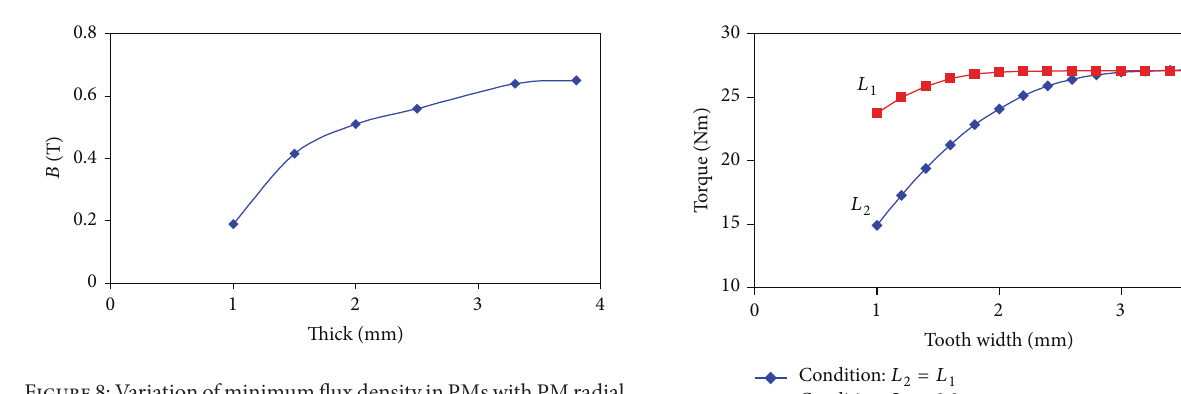
Figure 8: Variation of minimum flux density in PMs with PM radial . thickness 𝐻 pm